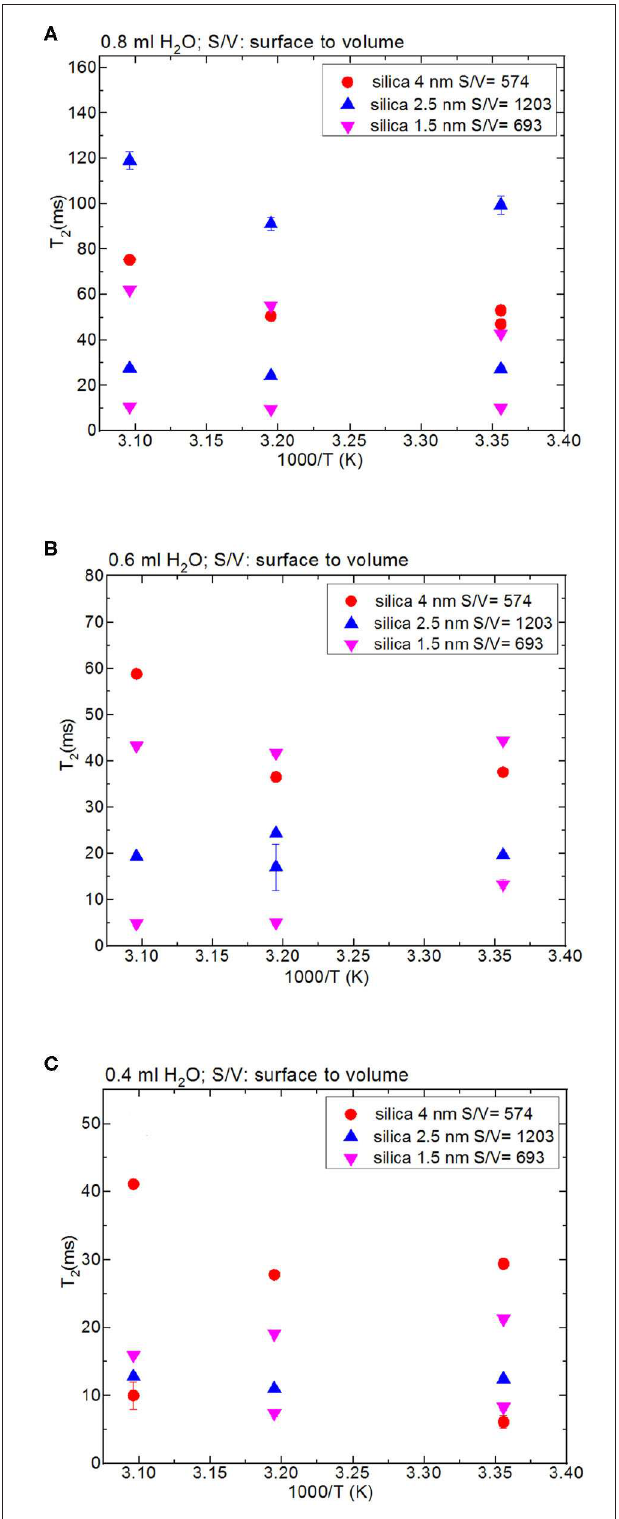
FIGURE 3 | Comparison of T 2 values of bulk water and water mixed with nanoporous silica where the variables are pore diameter nanoporous silica materials with the amount 150mg (silica-4.0nm, silica-2.5nm, silica-1.5nm) and temperature (298, 313, and 323K); 0.8ml water (A) , 0.6ml water (B) , 0.4ml water (C)